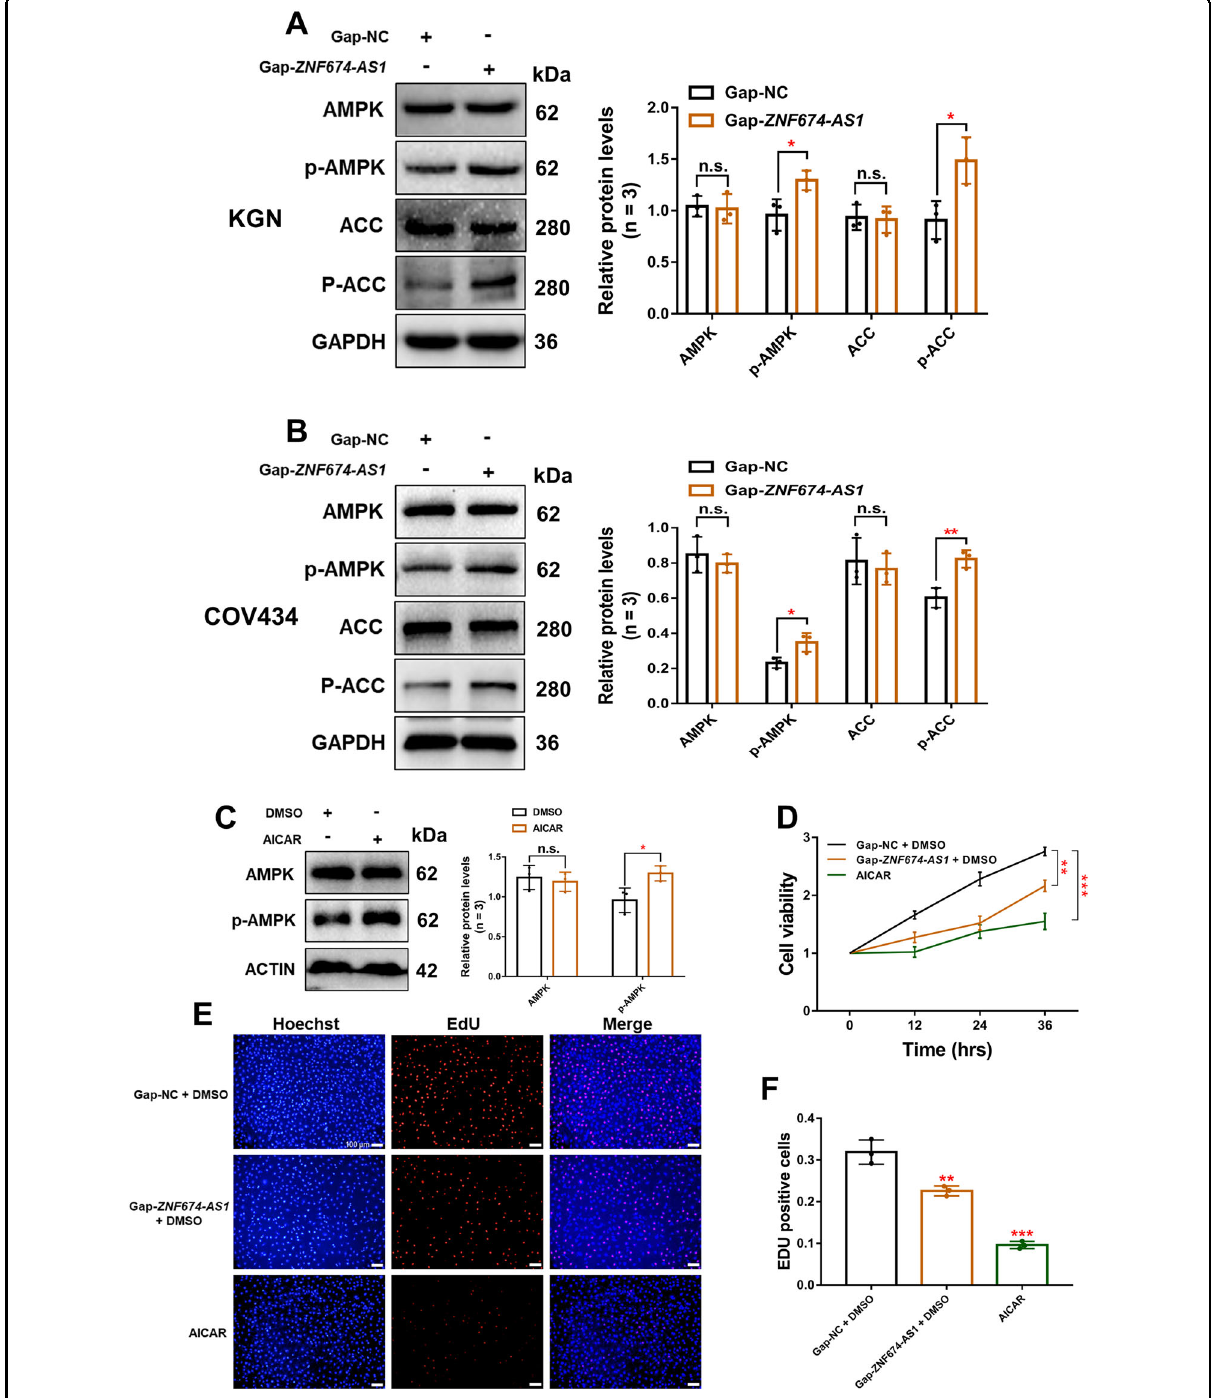
Fig. 5 The silence of ZNF674-AS1 promotes the activation of AMPK. A , B Western blot showing the levels of phosphorylated proteins of the AMPK signaling pathway in ZNF674-AS1 silenced and negative control KGN and COV434 cells. For gray value quanti fi cation of proteins, data were normalized to the internal reference. Shown are mean ± SD. n.s. no signi fi cance, * p < 0.05, ** p < 0.01 by two-tailed Student ’ s t test. C Western blot showing the phosphorylation of AMPK protein in AICAR or DMSO treated KGN cells. For gray value quanti fi cation of proteins, data were normalized to the internal reference. Shown are mean ± SD. n.s. no signi fi cance, * p < 0.05 by two-tailed Student ’ s t test. D The CCK8 assay showed the cell viability of ZNF674-AS1 silenced, AICAR treated and negative control KGN cells. Results are expressed as the mean ± SD ( n = 3). ** p < 0.01, *** p < 0.001 by two-tailed Student ’ s t test. E , F EdU staining assay showing the proliferation ability of ZNF674-AS1 silenced, AICAR treated, and negative control KGN cells. Results are expressed as the mean ± SD ( n = 3). ** p < 0.01, *** p < 0.001 by two-tailed Student ’ s t test. Scale bar: 100 μ